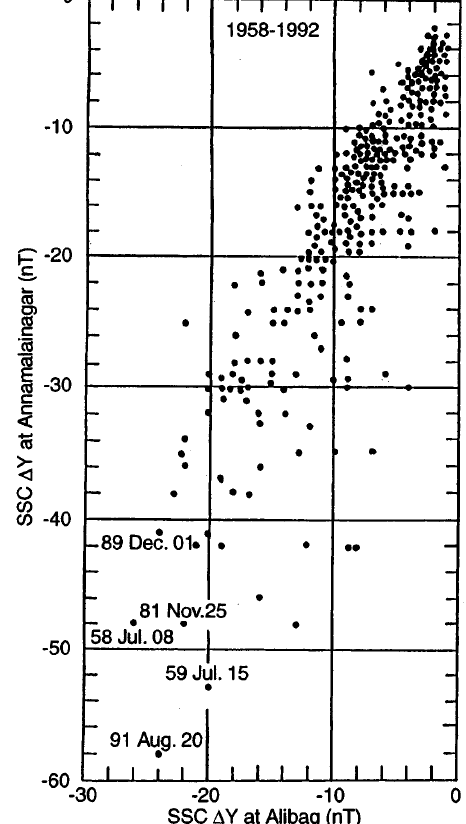
Fig. 9. Relationship between the individual amplitudes of H due to SSC at ABG , and ANN during daytime and nighttime for 1958–1992